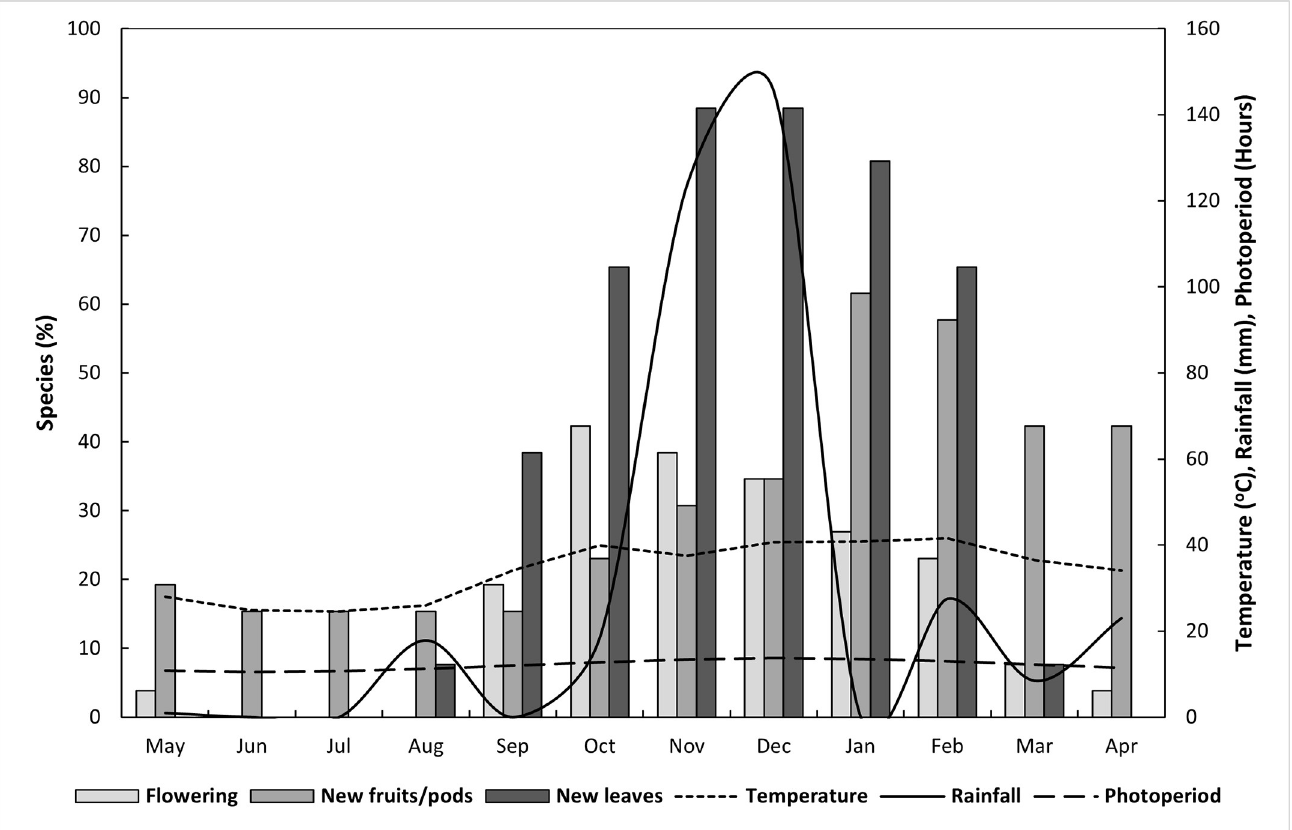
Fig 3. Effects of rainfall, temperature and photoperiod on percentage of woody plant species flowering, with new fruit/pods and with new leaves. https://doi.org/10.1371/journal.pone.0251421.g003 PLOS ONE | https://doi.org/10.1371/journal.pone.0251421 May 11,